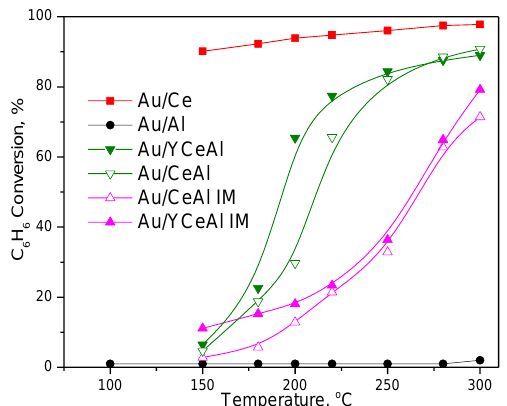
Figure 1. Temperature dependence of complete benzene oxidation (CBO) over gold-based catalysts.